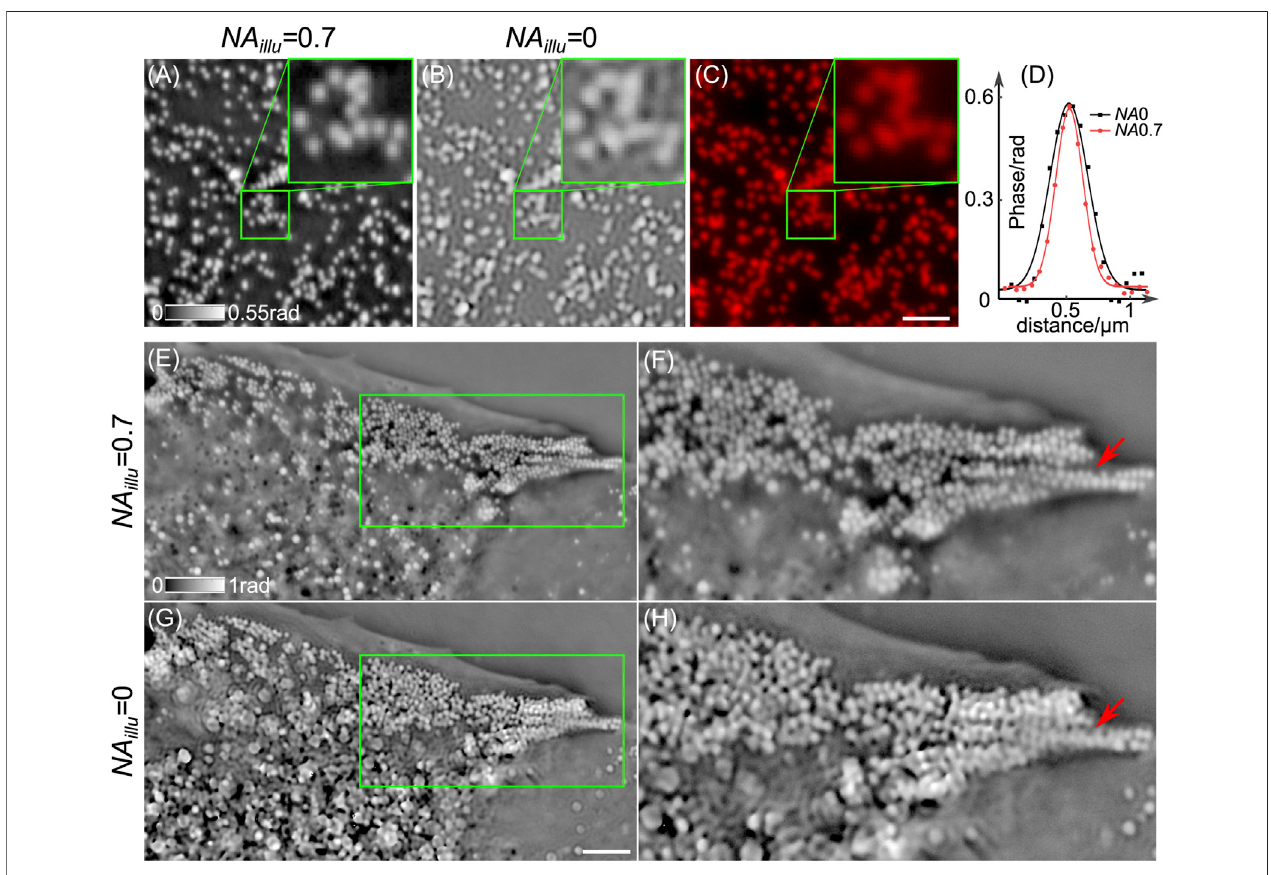
FIGURE 2 | CF-QPCM imaging of polystyrene spheres and lipid droplets inside live Cos7 cells. (A,B) The phase images of 200-nm diameter polystyrene spheres using CF-QPCM with annular illuminations ( NA illu = 0.7) and on-axis plane wave illumination ( NA illu = 0). (C) The fl uorescence image of the polystyrene spheres. (D) The pro fi les along the lines crossing the centers of a sphere in (A,B) . (E) and (G) The phase images of live a Cos7 cell obtained by CF-QPCM with annular illumination ( NA illu = 0.7) and on-axis plane wave illumination ( NA illu = 0). (F) and (H) The enlarged views in the green boxes in (E) and (G) show the superiority of NA illu -0.7 illumination over NA illu -0 illumination on resolving minute structures of samples. Scale bars in (C) and (G) : 2 and 4 μ